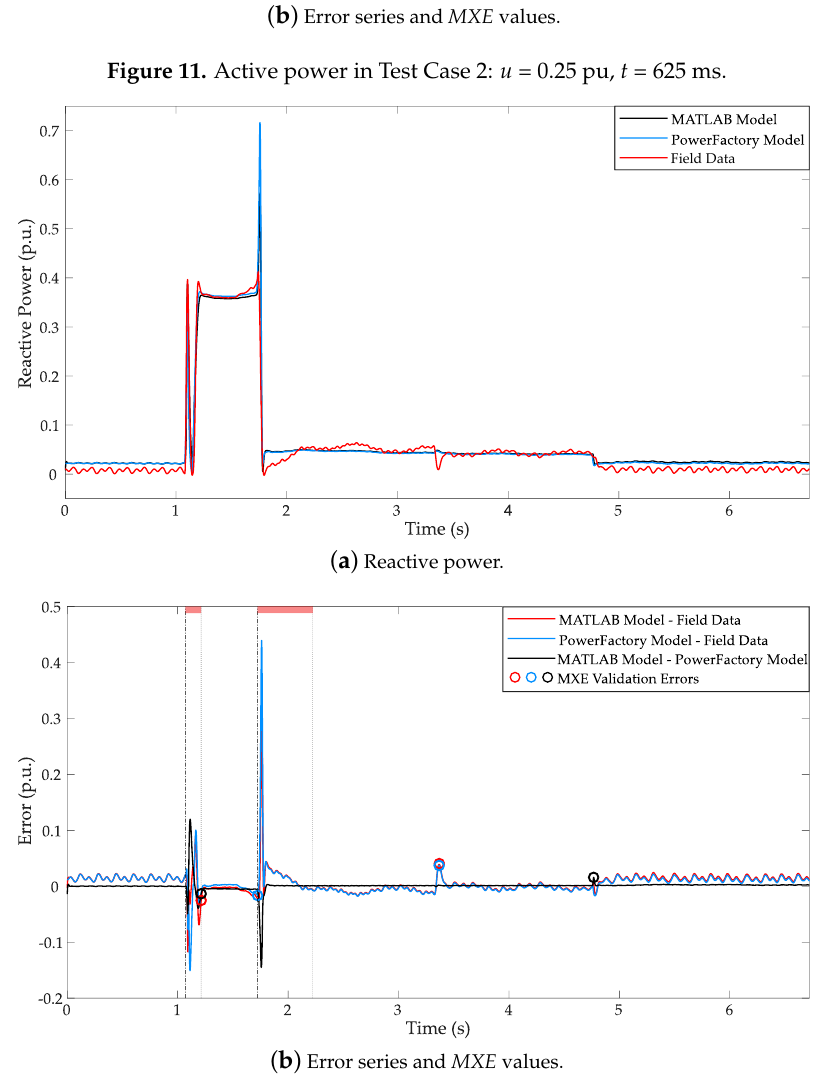
Figure 12. Reactive power in Test Case 2: u = 0.25 pu, t = 625